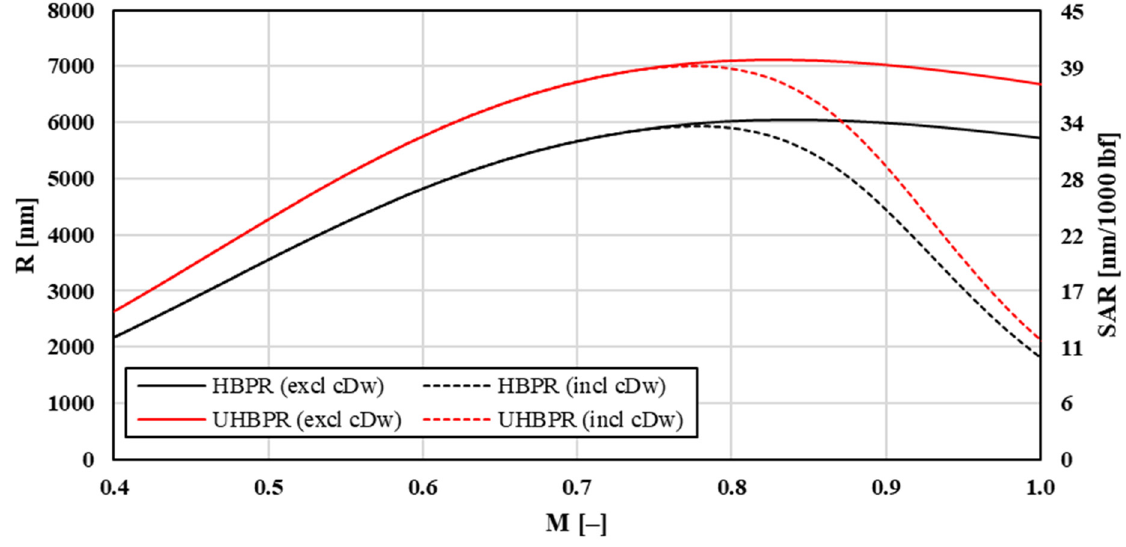
Figure 13. Range and SAR of the fictitious T-category airplane as a function of BPR and Mach number for both models, including and excluding wave drag.